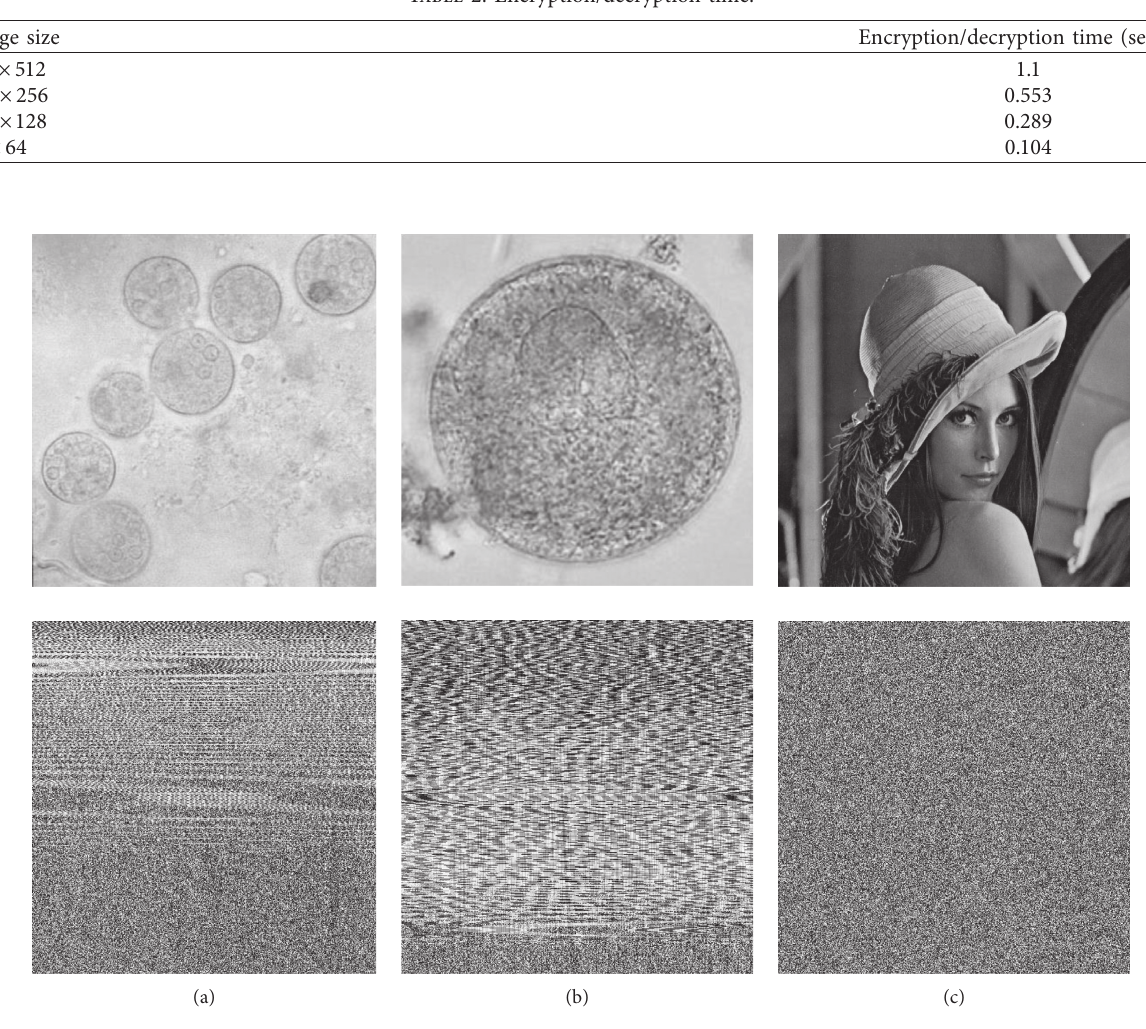
Figure 3: Effect of zigzag and affine transformation processes on some images using the external key «A23C56789AB- ADEF7167DEAB6789367A9»: (a) “Antamoebacoli” and its corresponding transformed image. (b) A plain image “Balantidum Coli cyst” and its corresponding transformed image. (c) A plain image “Girl (Lena, 4.2.04)” and its corresponding transformed image.